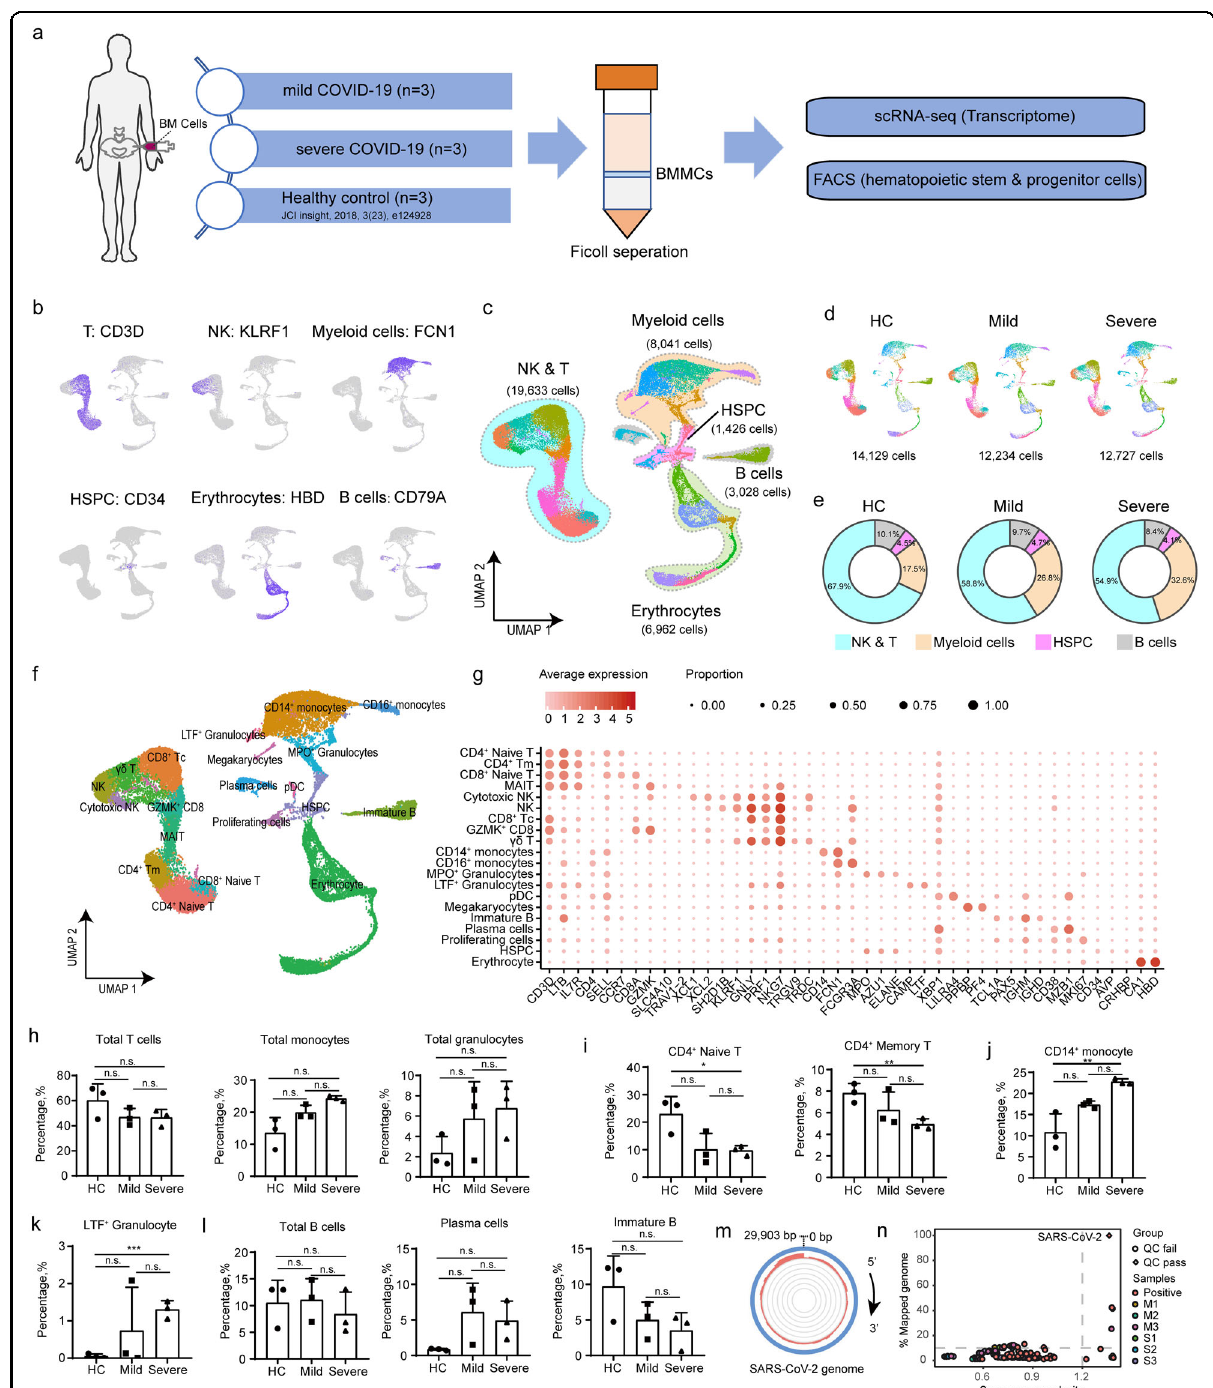
Fig. 1 (See legend on next